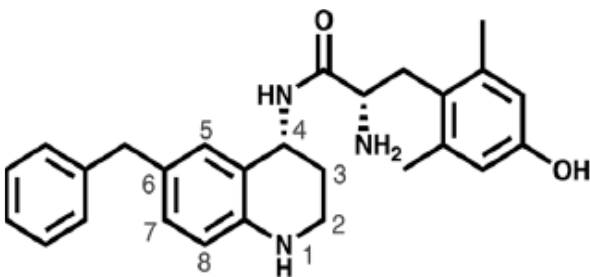
Figure 16. Peptidomimetic lead compound concomitantly acting as μ-opioid receptor agonist and δ-opioid receptor antagonist.